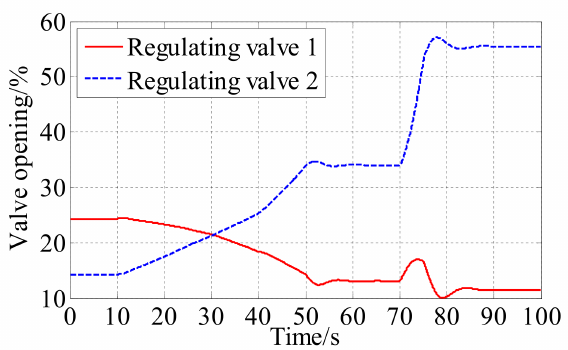
Figure 26. Opening of regulating